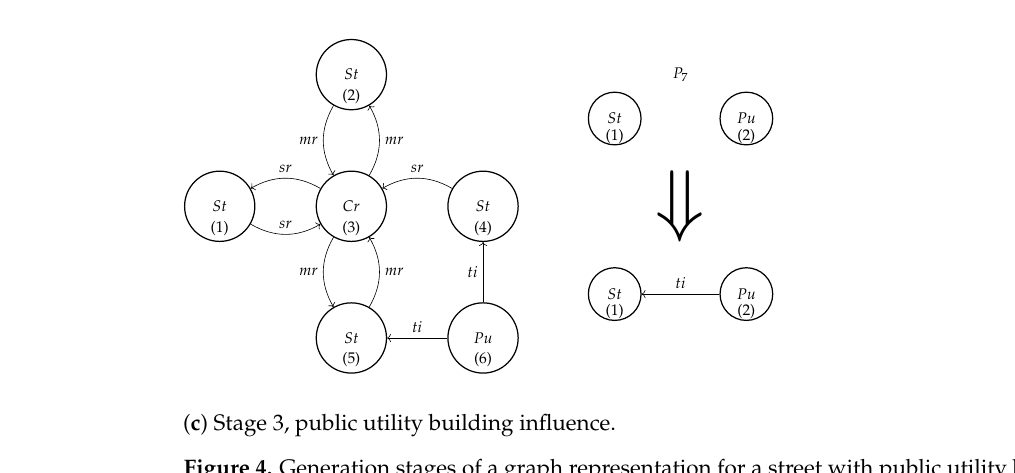
Figure 4. Generation stages of a graph representation for a street with public utility buildings.